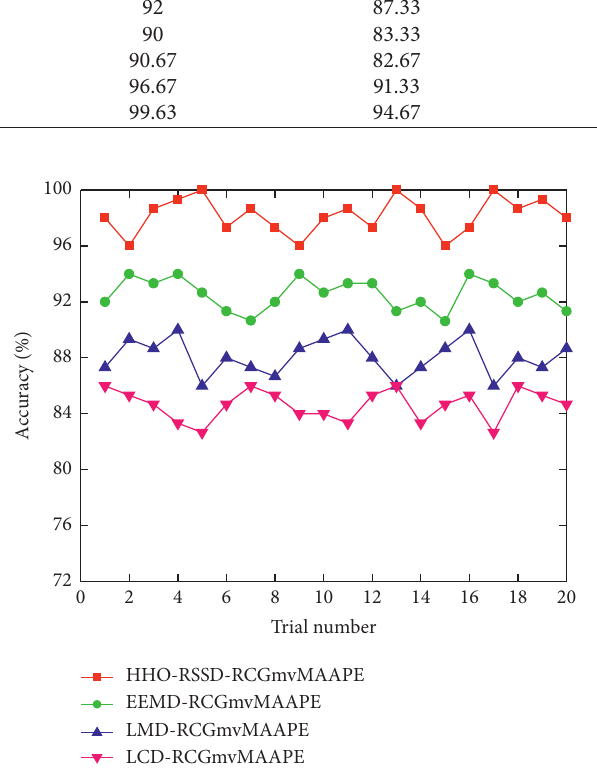
Figure 24: The diagnostic result of four signal decomposition